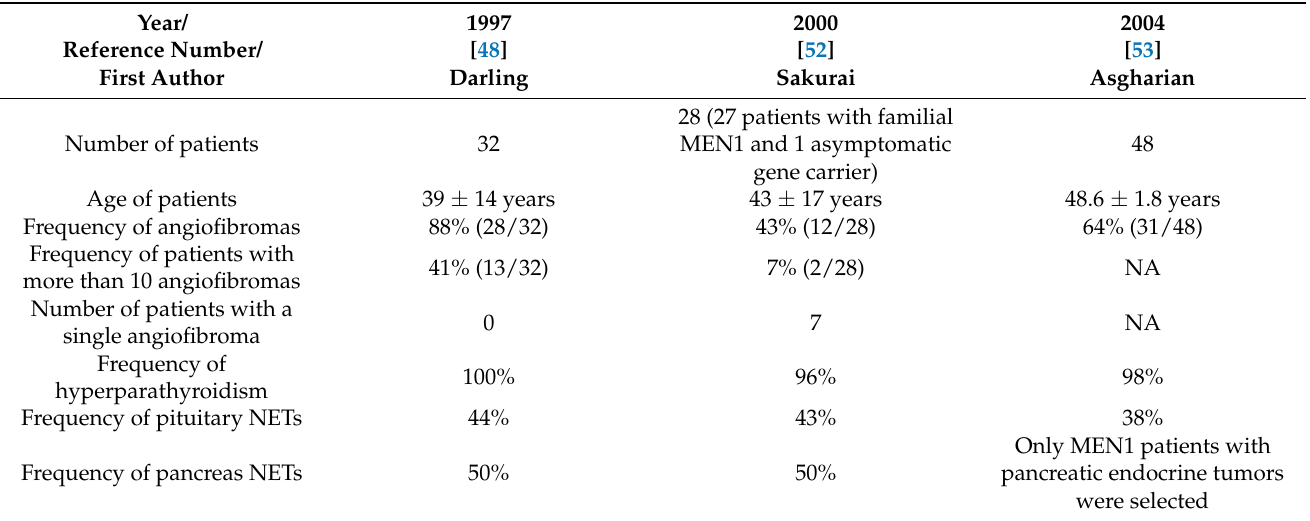
Table 3. Analysis of angiofibromas in Caucasians [48], Japanese [52], and United States citizens diagnosed with MEN1